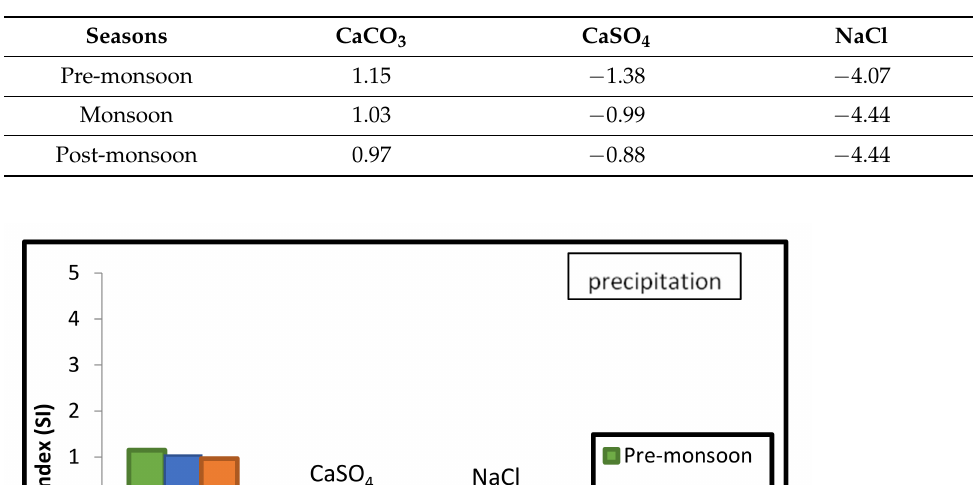
Table 2. SI values of CaCO 3 , CaSO 4 and NaCl using PHREEQC model.